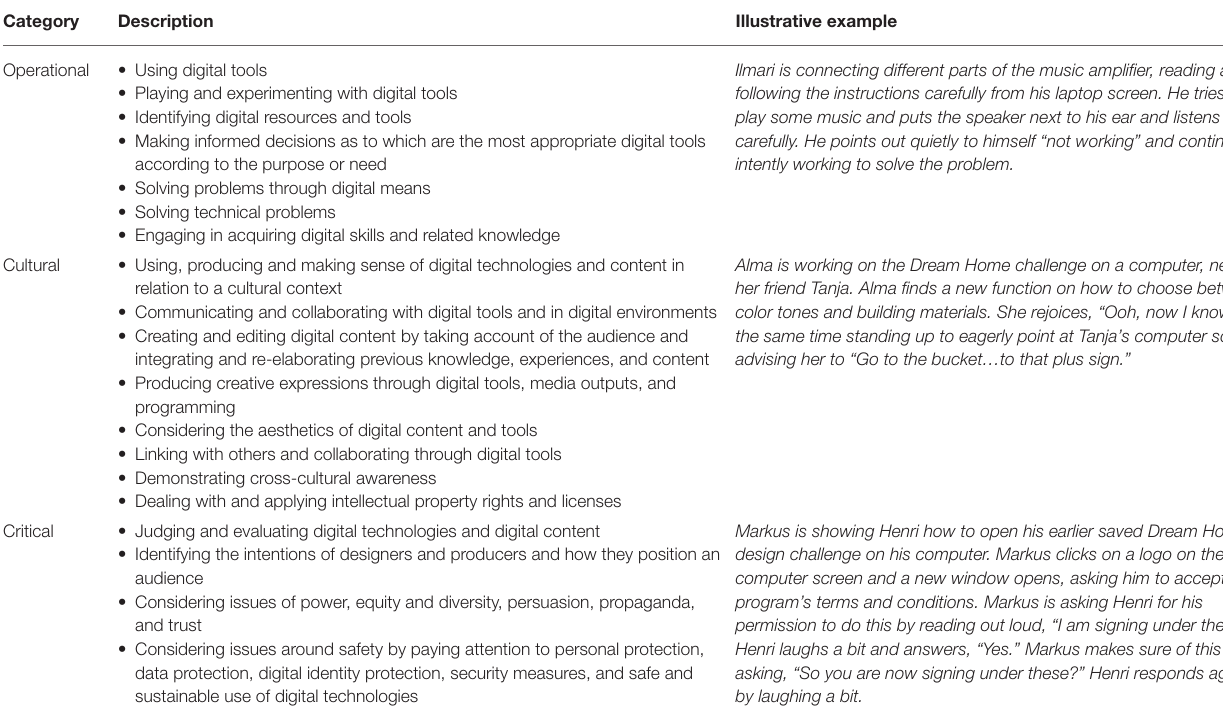
TABLE 3 | An analysis framework of maker literacies. Category Description